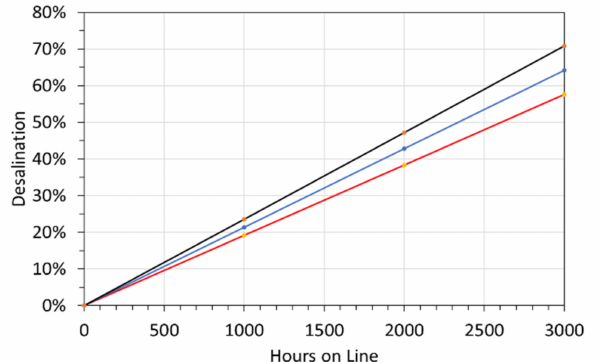
Figure 13. Example relationship for the expected desalination as a function of time. Determined for feed water with a salinity of 5 g L − 1 . Red line = 90% probability of a greater desalination. Blue line = mean outcome; black line = 10% probability of a greater desalination. Water containing 20–30 g ZVI treatment product L − 1 is expected to cease desalinating after 1500–2000 h. Water containing 50–60 g ZVI treatment product L − 1 is expected to cease desalinating after 2500–4000